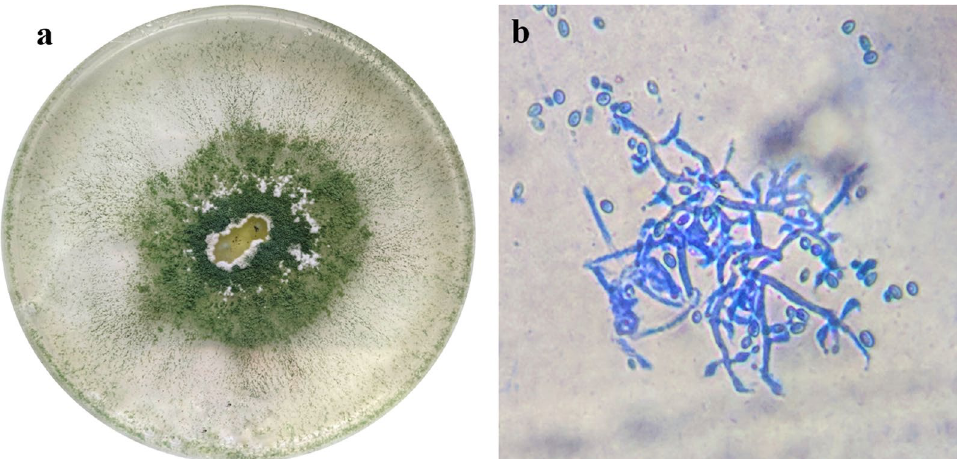
Fig. 1 Morphology of Trichoderma longibrachiatum (T10) a colony on PDA after 4 days, b microscopic observation of the fungus showing phialides and